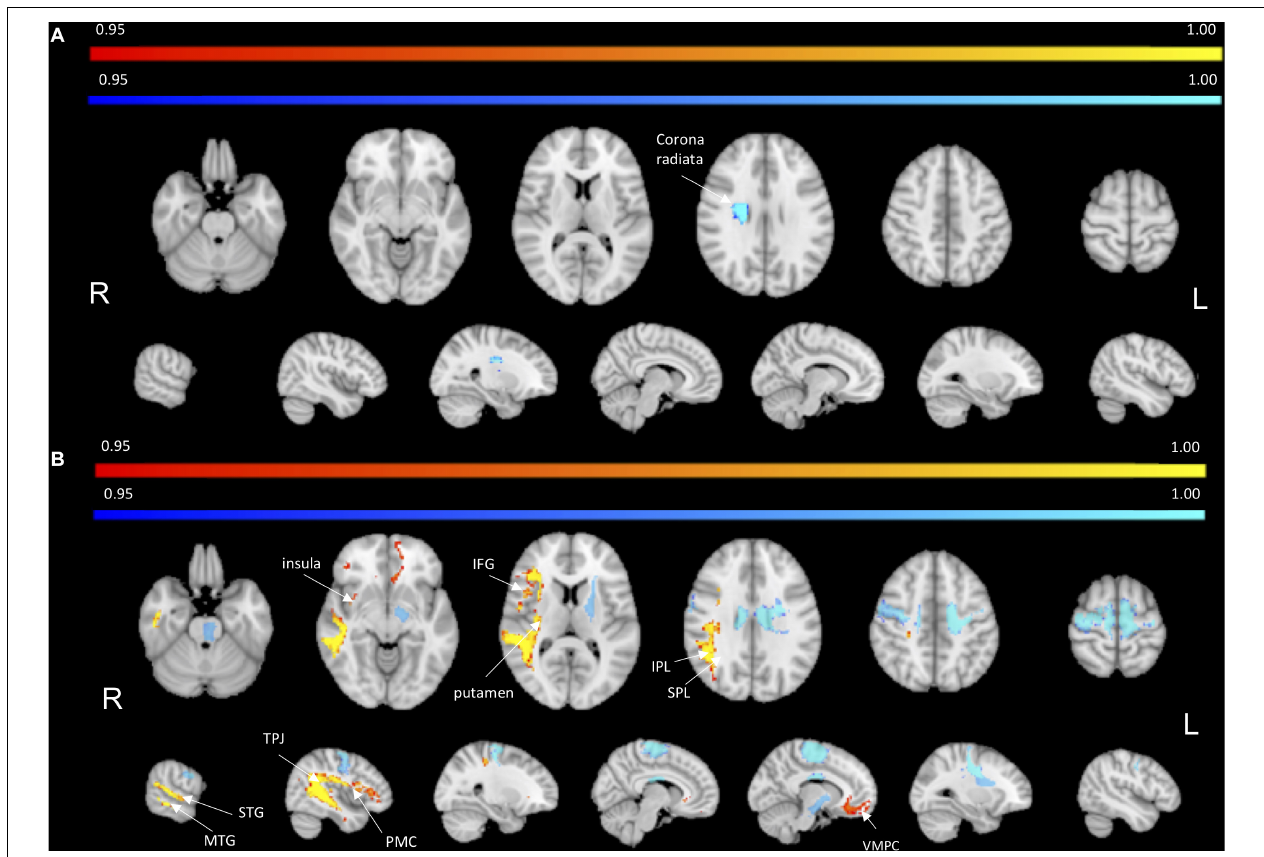
FIGURE 3 | Lesion vs. disconnection maps. (A) Lesion-based mapping: voxels with significant difference in lesion frequency between HP and AHP patients. HP > AHP ( p < 0.05) (blue-teal). No voxels for AHP > HP damage. (B) Disconnection-based maps: voxels showing significant difference in white matter disconnection. HP > AHP ( p < 0.05) (blue-teal). AHP > HP ( p < 0.05) (orange–yellow).